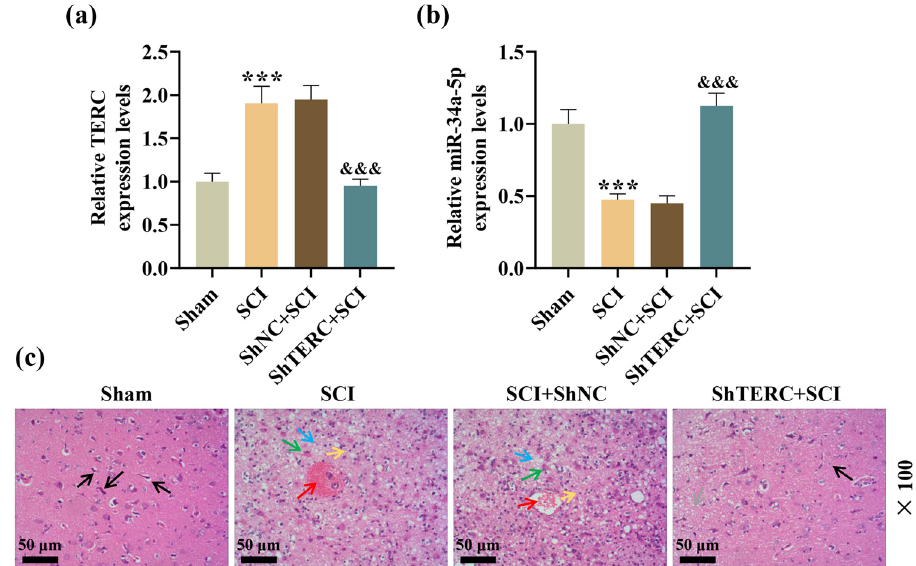
Figure 1: Knockdown of TERC, which was upregulated in SCI, revoked miR - 34a - 5p downregulation, and alleviated histopathological abnormalities in the spinal cord of SCI rats. ( a and b ) The expressions of TERC and miR - 34a - 5p in the spinal cords of SCI rats were analyzed by qRT - PCR. ( c ) Spinal cord histopathological changes were examined via hematoxylin – eosin staining ( magni fi cation: × 100; scale: 50 µm; black arrows: a basically complete and regular organizational structure; blue arrows: a relatively disorganized organizational structure; yellow arrows: pyknosis and degeneration of the nucleus; green arrows: obviously loose and edematous interstitium; red arrows: local congestion and bleeding; gray arrows: slightly loose interstitium ) . *** P or &&& P < 0.001; * vs Sham; & vs ShNC + SCI.